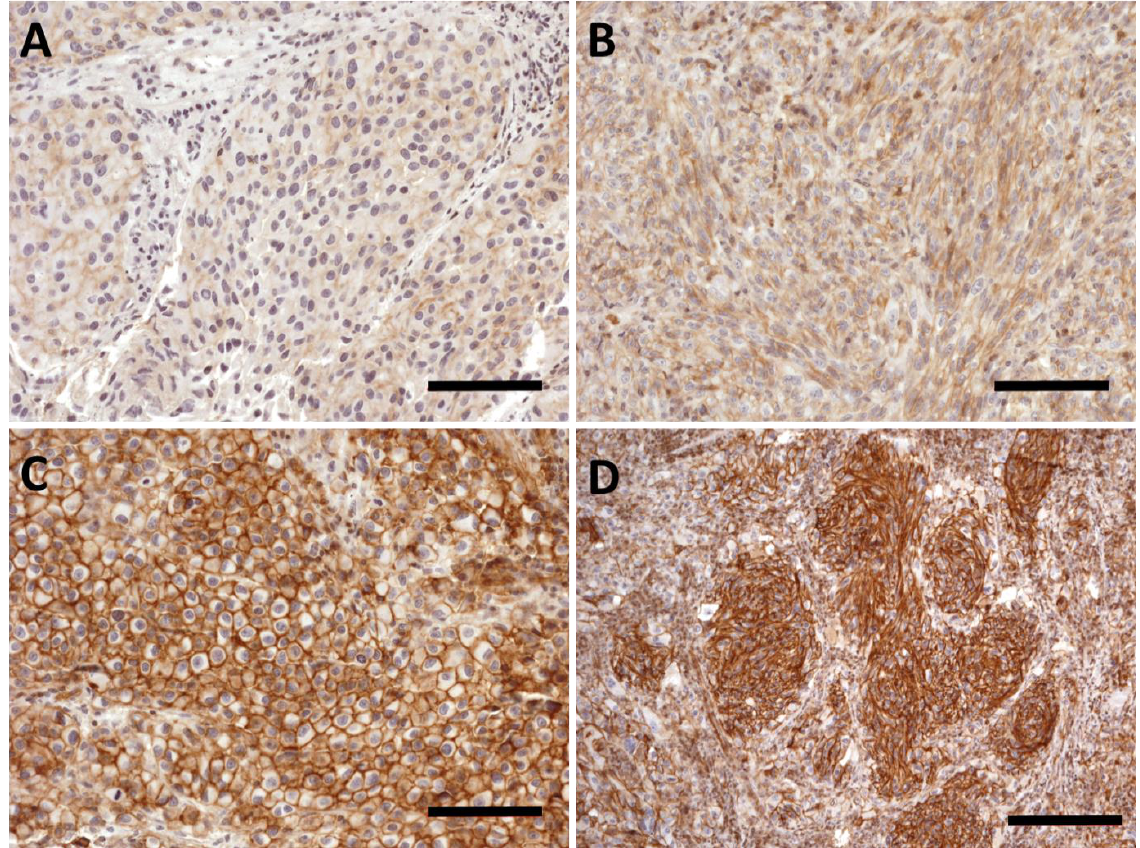
Figure 5. PMCA4b expression in melanoma lung metastasis. ( A ) Weak but clear plasma membrane- specific PMCA4b staining in a lung metastasis. ( B ) Intermediate intensity staining. ( C , D ) High PMCA4b expression in epitheloid ( C ) and spindle cell ( D ) melanoma. Scale bar: ( A – C ): 100 µm; ( D ): 200 µm. Table 3. Clinicopathological characteristics of the melanoma lung metastasectomy cohort.